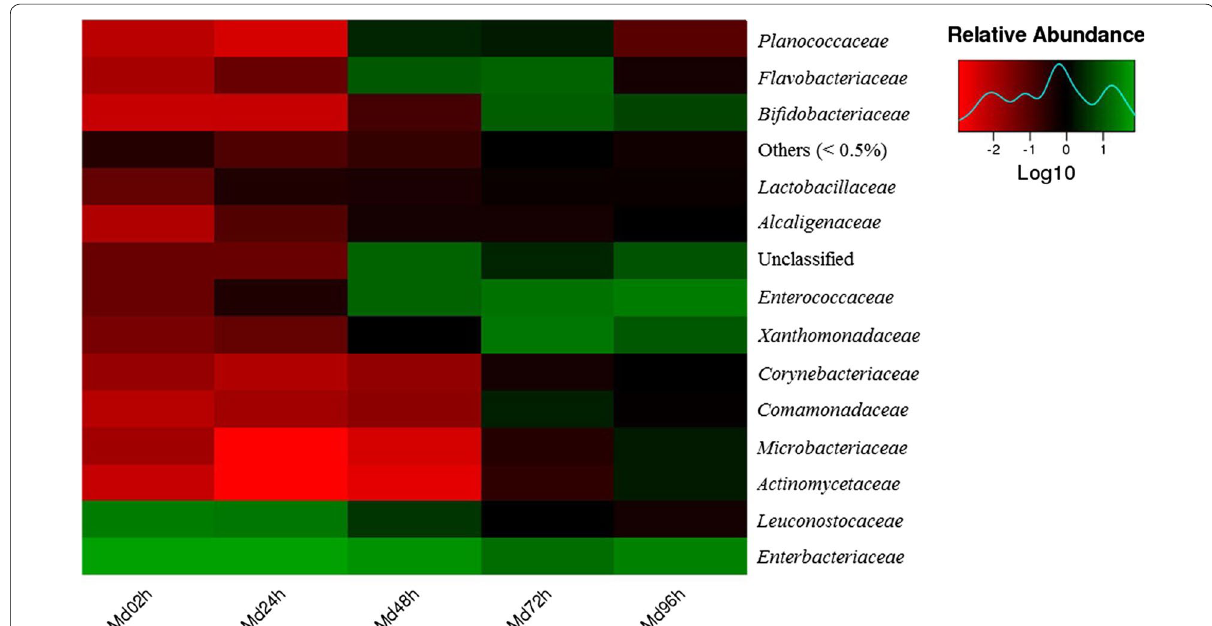
Fig. 2 Heat maps of the relative abundances and distributions of bacterial families in Musca domestica larvae. The colour code indicates relative abundance, ranging from red (low abundance) to black to green (high abundance). Each treatment included three biological replicates. To minimize the degree of difference in relative abundance values, all values were log transformed